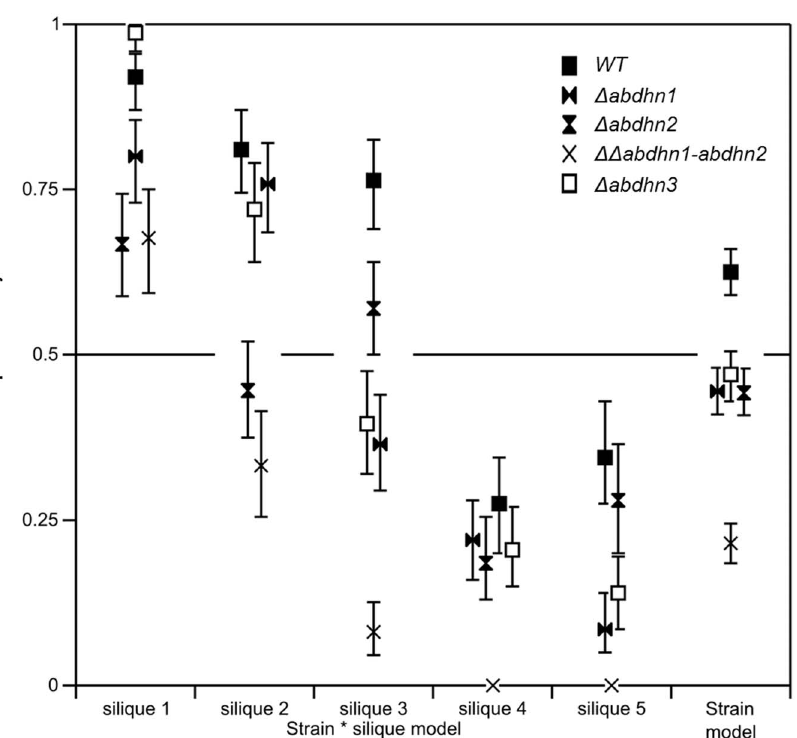
Figure 12. Transmission capacity of A.brassicicola wild-type (WT) and AbDhn-deficient genotypes to Arabidopsisthaliana seeds (L er ecotype). The seed transmission capacity according to the silique stage and global seed transmission capacity (strain model) were measured as described by Pochon et al [26]. The five youngest siliques of at least five plants were inoculated with each fungal genotype and the experiment was repeated twice. Contaminated siliques were harvested 10 dpi. After dissection, seeds were incubated separately on PDA medium for 2 days. A seed was considered contaminated when incubation resulted in typical A. brassicicola colony development. For each inoculated fungal genotype, the seed infection probability was evaluated from at least 1000 seeds. Values represent infection probabilities with 95% confidence